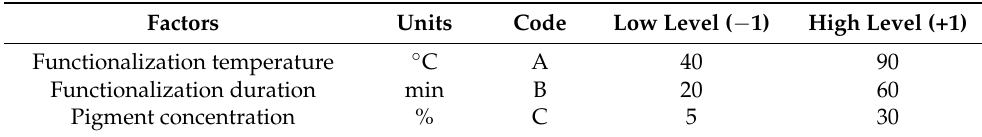
Table 1. Factors and levels used in the two-level full factorial design. Additionally, three replications were performed at the central point. Factors Units Code Low Level ( − 1) High Level (+1) Functionalization temperature ◦